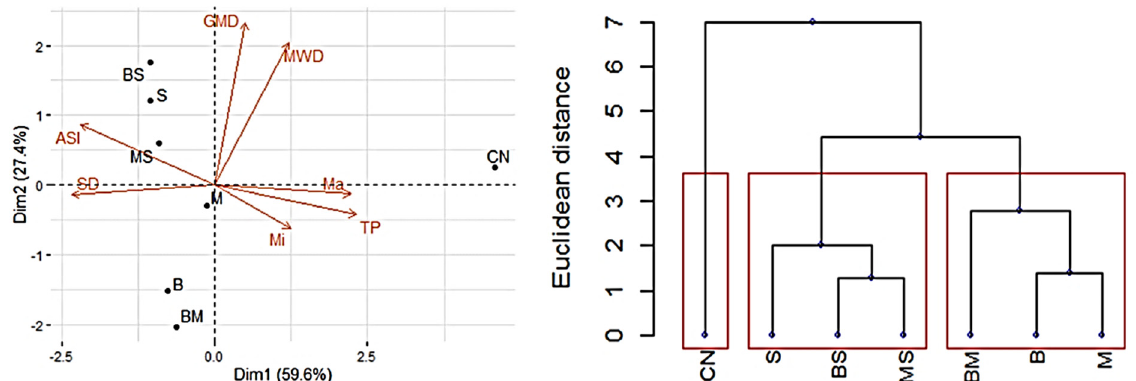
Figure 3. Principal components analysis, and cluster analysis of cover crops and Cerrado native area (CN) (0.1–0.2 m soil depth). M = pearl millet, B = brachiaria, S = sunn hemp; BM = B + M; BS = B + S; MS = M + S; CN = Cerrado native. SD = Soil bulk density; Ma = Soil macroporosity; Mi = Soil microporosity; TP = Soil total porosity; MWD = Mean weight diameter; GMD = Geometric mean diameter; ASI = Aggregate stability index. The SD for B = 1.78; M = 1.73; S = 1.72; B + M = 1.71; B + S = 1.77, and M + S = 1.75 kg dm − 3 ,